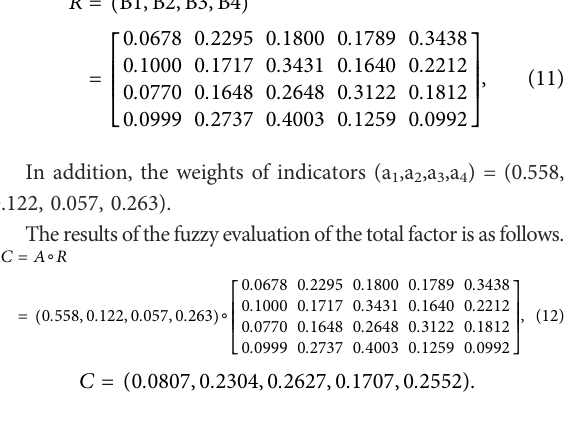
TABLE 7 Weights of second-tier indicators